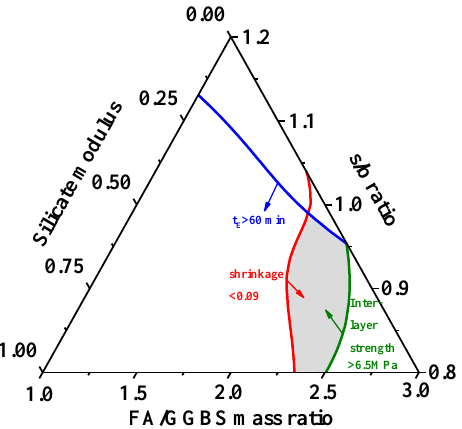
Figure 12. The contours of properties of 3D-AAFS mortar. ( a ) t E contour, ( b ) t B contour, ( c ) interlayer bond strength contour, and ( d ) drying shrinkage contour.